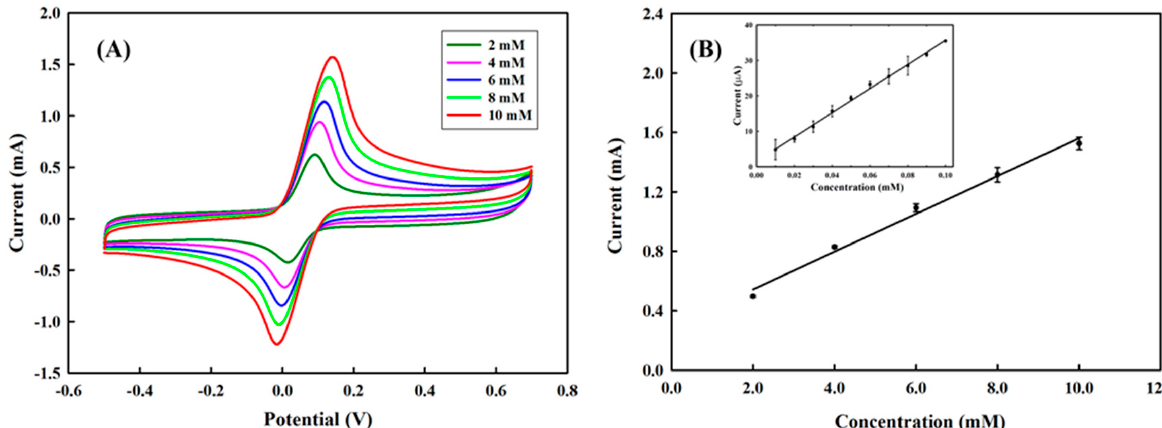
Figure 4. ( A ) The cyclic voltammetry profiles of PEDOT/PL electrode in response to different concentrations of hydroquinone (2 to 10 mM). ( B ) The linear correlation between the anodic peak current and the concentration of hydroquinone. The inlet indicated the linear correlation for a low concentration of hydroquinone (10–100 µ M). The measurements were carried in 100 mM of PBS buffer. The potential was swept from − 0.5–0.7 V with the rate of 100 mV s − 1